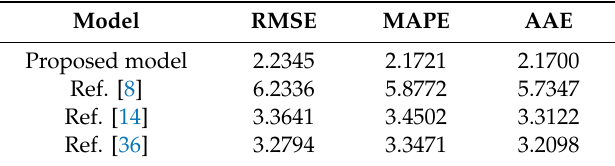
Table 3. Comparison with the prediction results of the references’